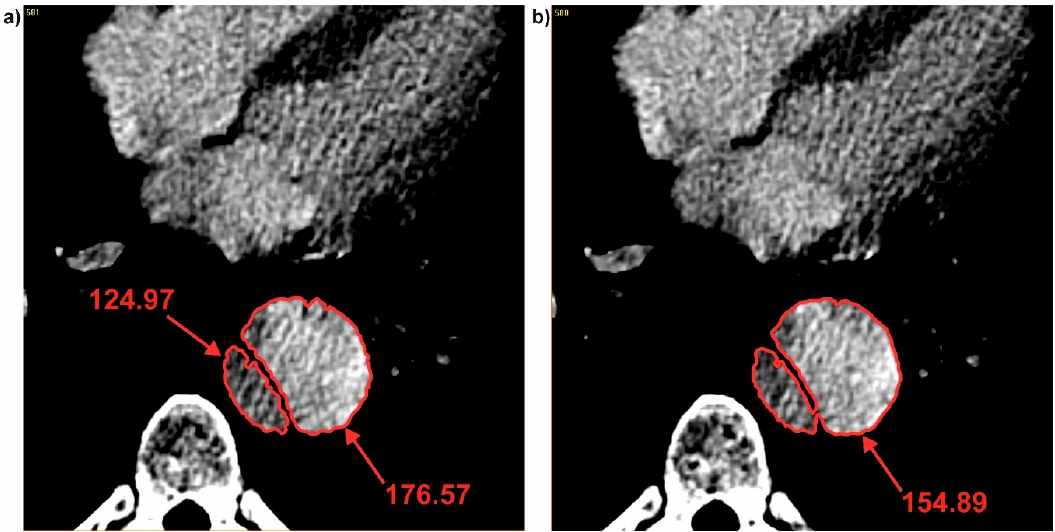
Figure 9. Brightness changes during channels connection: ( a ) Common duct and ( b ) true and false duct. Values of brightness were calculated in pixels.